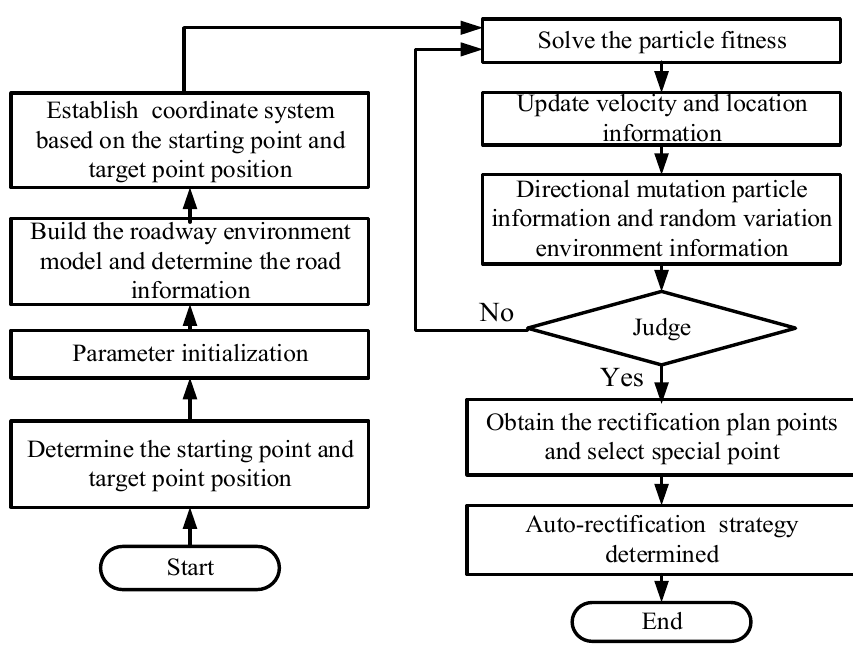
Figure 10. The variable particle swarm in the rectification